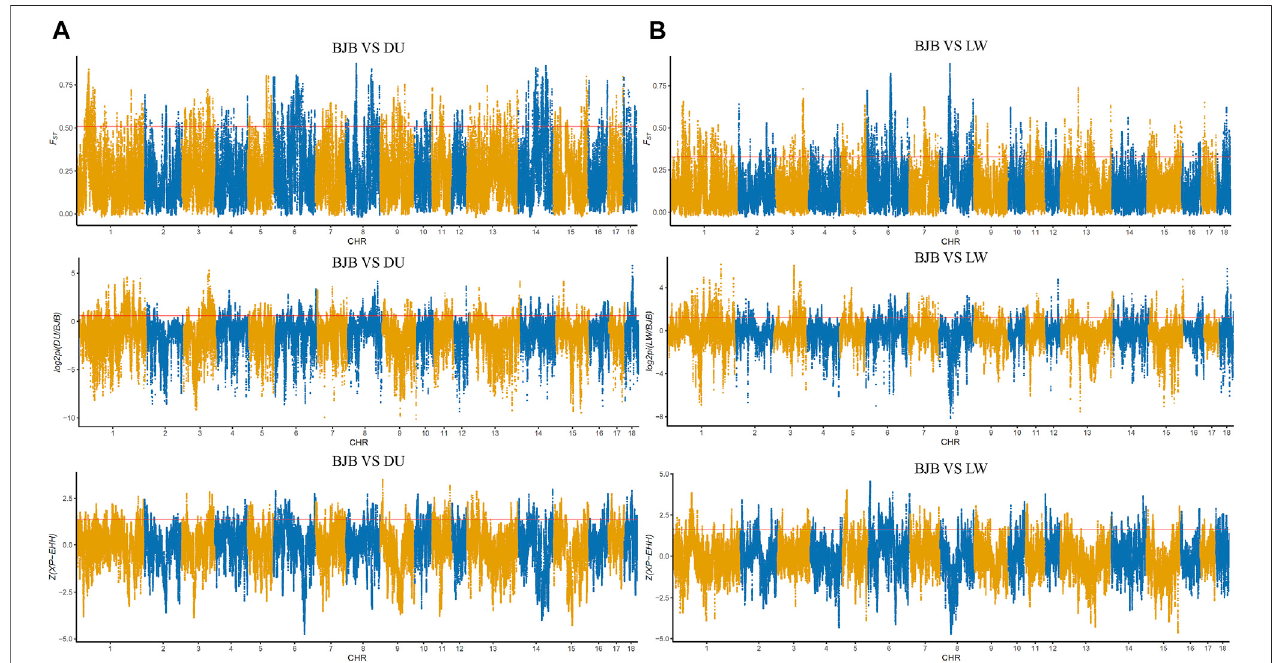
FIGURE 4 | Genome-wide distribution of selection signatures detected by F ST , θπ , and XP-EHH on 18 chromosomes from top to bottom. X -axis represents 18 autosomes, and Y -axis represents statistic values of each method. The θπ values are log2 normalized, and the XP-EHH values are standardized. Red line displays the threshold level of 5%. (A) Global distribution of statistic values of three methods between Beijing Black pigs and Duroc. (B) Global distribution of statistic values of three methods between Beijing Black pigs and Large White.